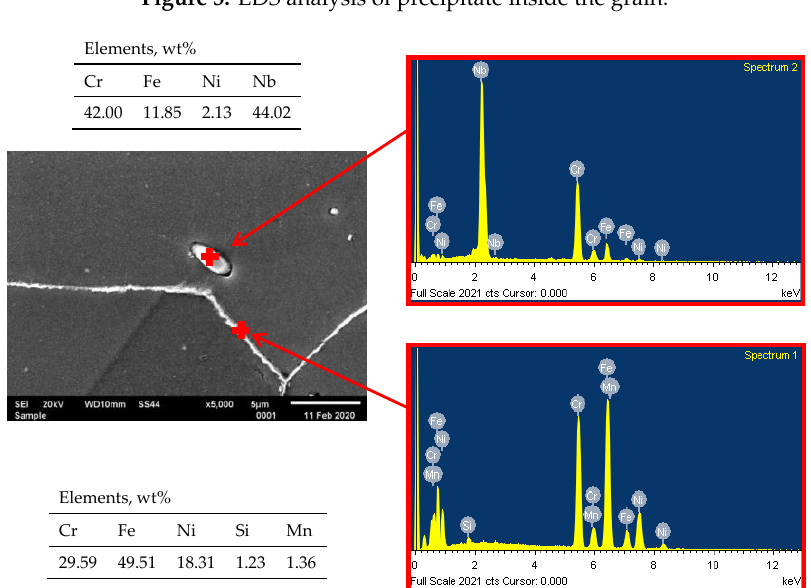
Figure 4. EDS analysis of precipitate inside the grain and at the grain boundary.